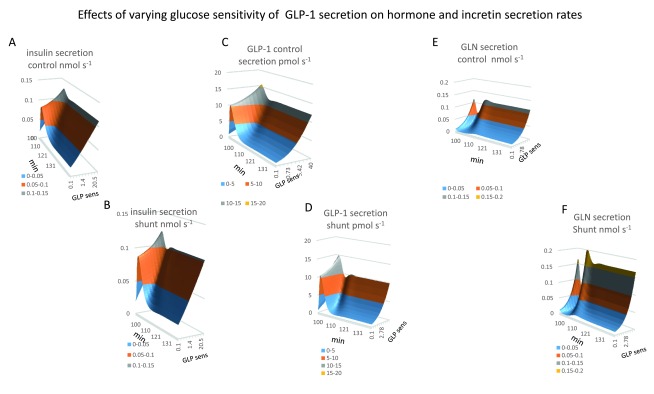
Effects of GLP-1secretion on the time course of insulin secretion.
Panel 9A. Insulin secretion rates are increased during the glucose absorptive phase of metabolism. This increase is stimulated directly be systemic glucose concentration and by the glucose sensitivity of GLP-1secretion. During fasting insulin secretion rates are directly proportional to GLP-1glucose sensitivity however during peak glucose absorption insulin secretion rates vary to a much lesser extent as with low rates of GLP-1systemic glucose is raised and therefore compensates for lack of glucose sensitivity of GLP-1secretion. 1 (
K
½GLP-1gluc sens = 0.80, V
max= 0.41 nmol s
-1)

Panel 9B Insulin secretion rates with PSS (
K
½GLP-1gluc sens = 0.72, Vmax0.375 nmol s
-1)

Panel 9C GLP-1secretion is very similar to insulin, GLP-1secretion increases rapidly during the glucose absorptive phase of metabolism and tails of splanchnic glucose is diminishes during the course of metabolism. During fasting GLP-1secretion is hyperbolically dependent on glucose as glucose sensitivity of GLP-1
K
½ = 4.4 Vmax 12.3 12 pmol s
-1) secreting cells in splanchnic blood is concentrations are lower with high rates of GLP-1secretion (
Figure 4G).
Panel 9D
GLP-1secretion with PSS glucose sensitivity of GLP-1
K
½ = 4.6 Vmax10.3 pmol s
-1 Shunting reduces insulin secretion by approximately 20%.

Panel 9F
Shunting increases glucagon secretion rates. The increase is a hyperbolic function of GLP-1 glucose sensitivity
(K
½ = 6.7 Vmax = 0.12 nmol s
-1). During glucose absorption glucagon secretion rates decrease as systemic glucose increases. The decrease is negligible with low rates of GLP-1secretion due to the slow rise in systemic glucose.